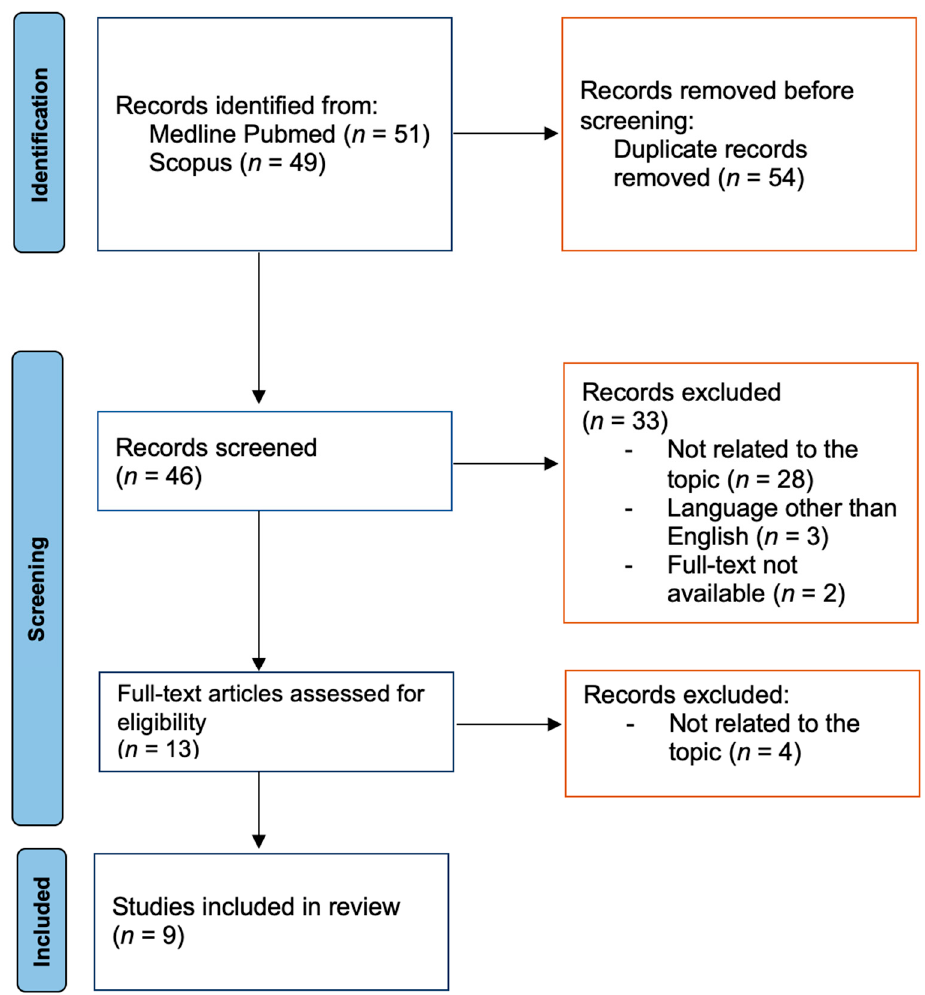
Figure 1. Study selection flowchart [18].